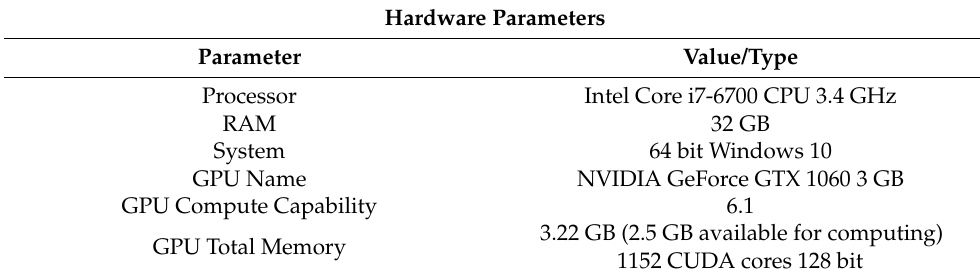
Table 4. The hardware and software used in the